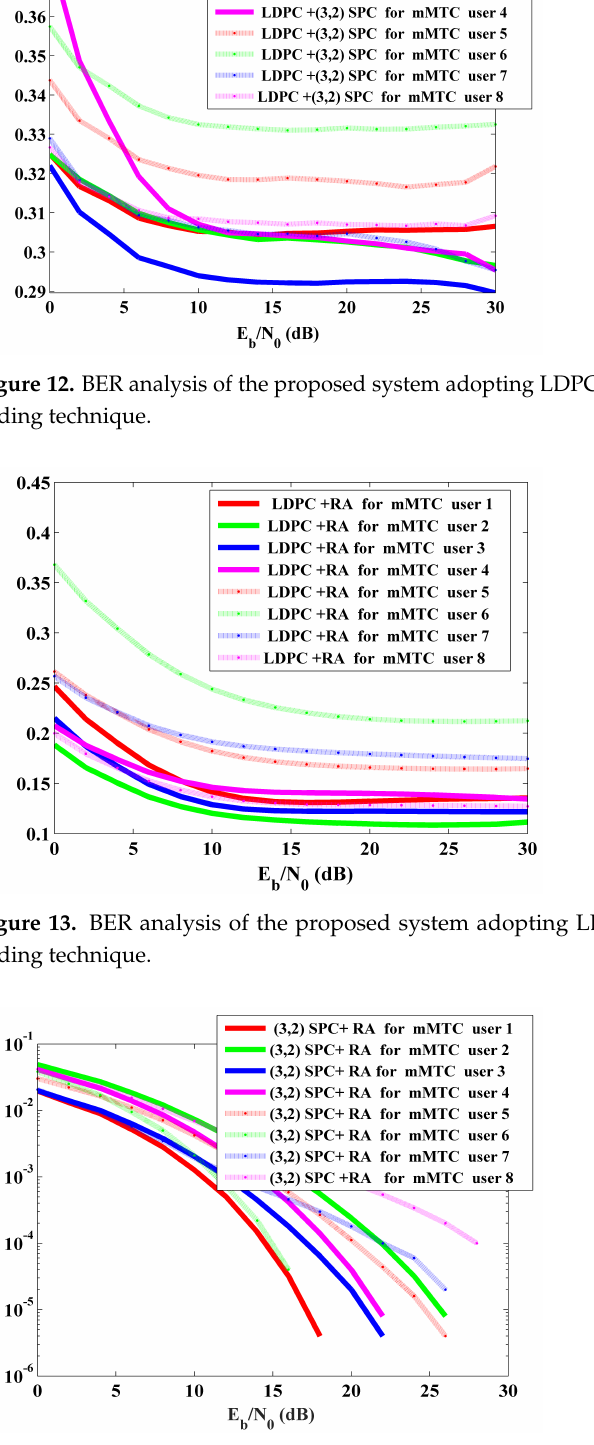
Figure 14. BER analysis of the proposed system adopting (3,2) SPC and RA concatenated channel- coding